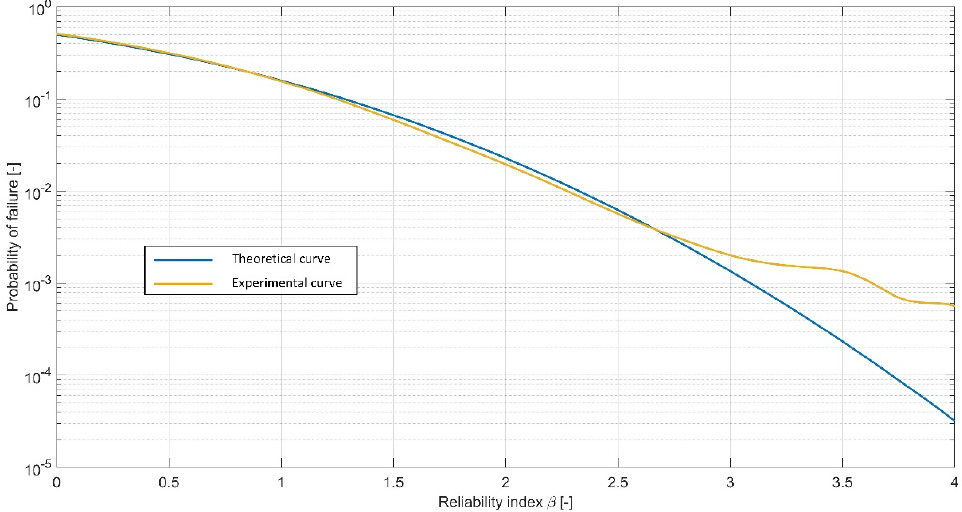
Figure 10. Probabilities of failure and respective reliability indices for levee slope stability.